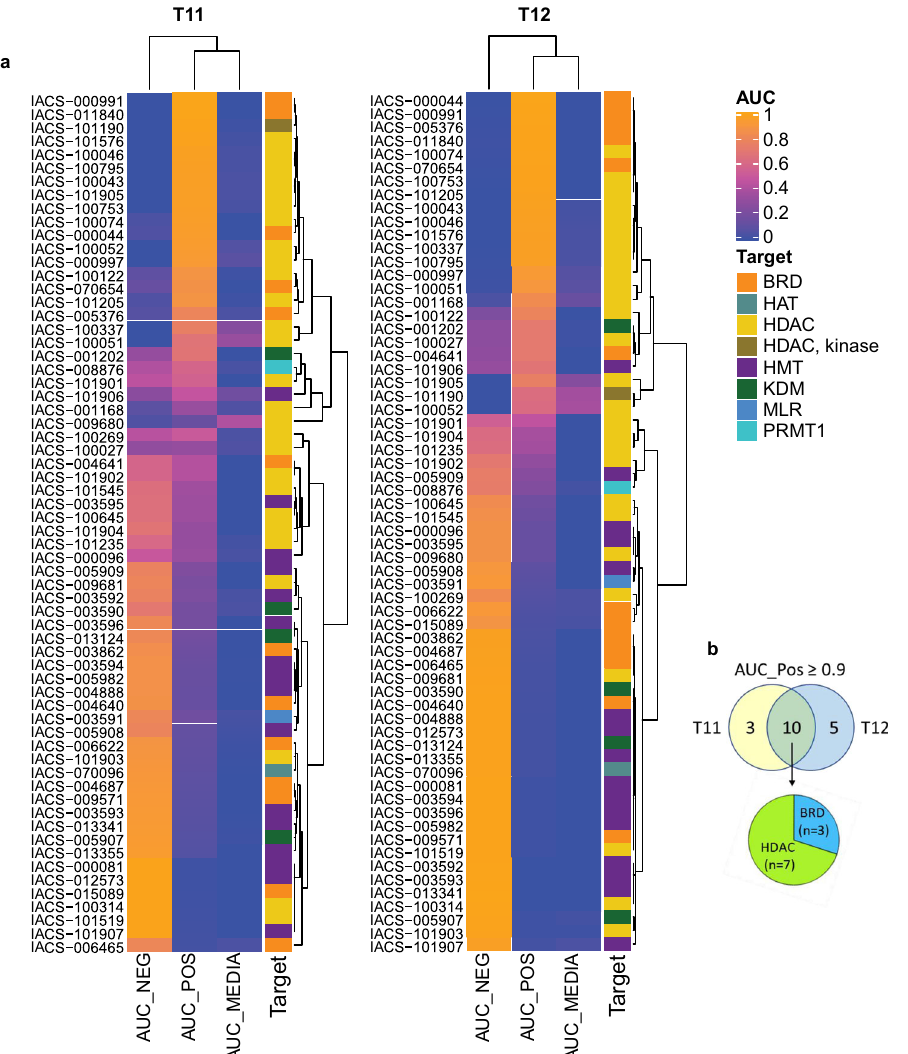
Fig. 3 EMT-reversing epigenetic drug screening in organoid cultures. a Clustered heatmap of IACS epigenetic drug library screening in T11 and T12 organoids. Drug-treated organoids were assigned a continuous ranking of drug activity (represented by area under the dose – response curve, AUC) for each of the three mapped categories: NEG (no effect, DMSO-like), POS (reduced branching structures, miR-200c induction-like), or MEDIA (no organoid present). Support vector regression was used to fi t probability of each class across concentrations, and clustering was done based on these values. The known molecular targets for each drug are shown in the annotation column. The description of each IACS drug is shown in Supplementary Data 1. b Venn diagram showing overlapping top positive-like drug hits and their target categories in T11 and T12 models. BRD bromodomain, HAT histone acetyltransferase, HDAC histone deacetylase, HMT histone methyltransferases, KDM histone lysine demethylase, MLR methyl-lysine reader, PRMT1 protein arginine methyltransferase